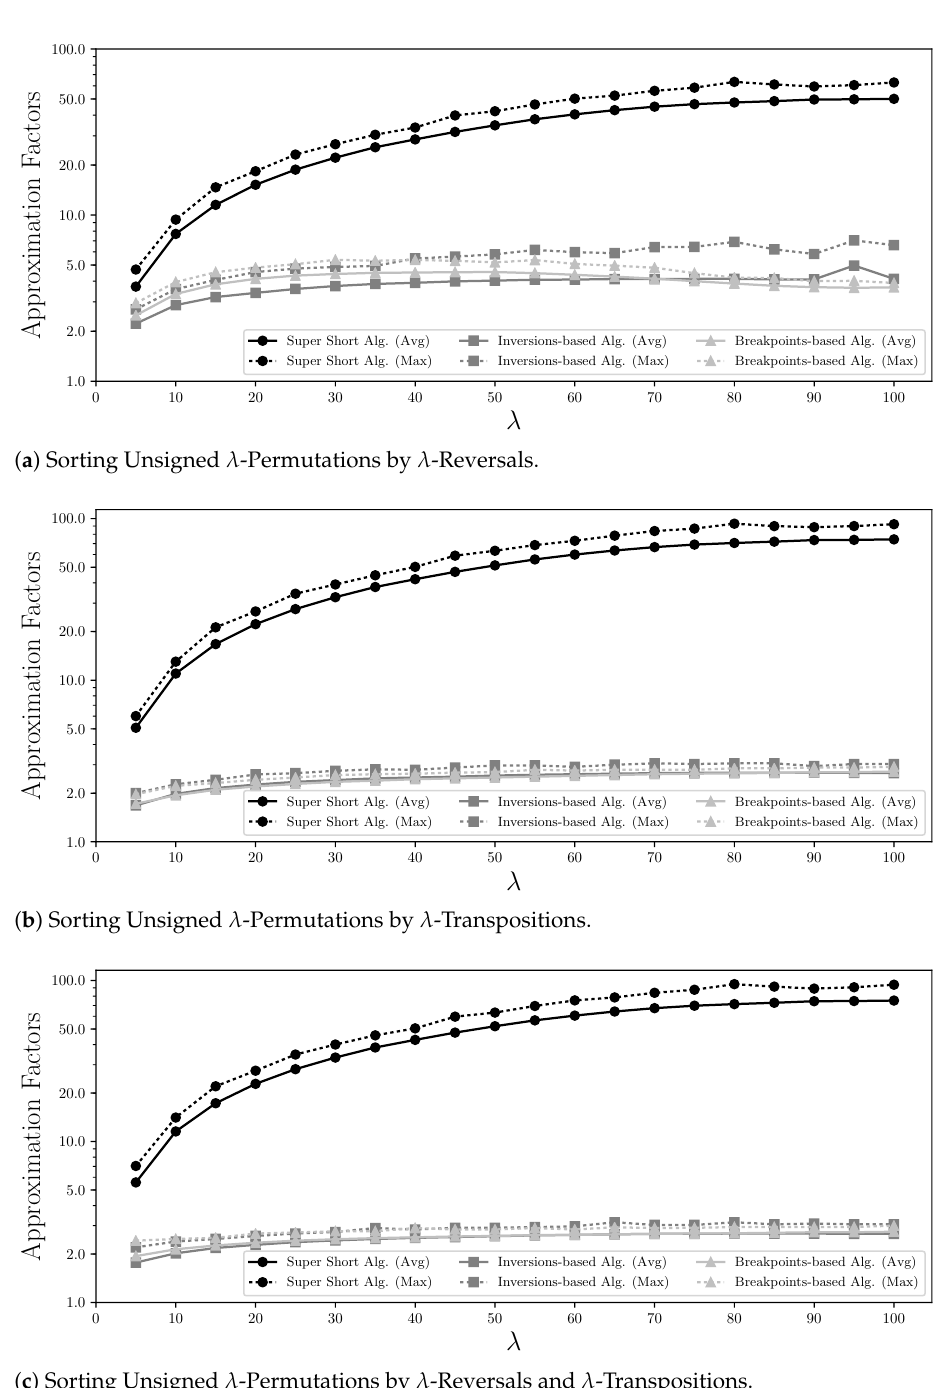
Figure 2. Average and maximum approximation factors of the algorithms for Sorting Unsigned λ -Permutations by λ -Operations, with totally random λ -permutations of size 100 as inputs. Note that a logarithmic scale is used in the y-axis of each